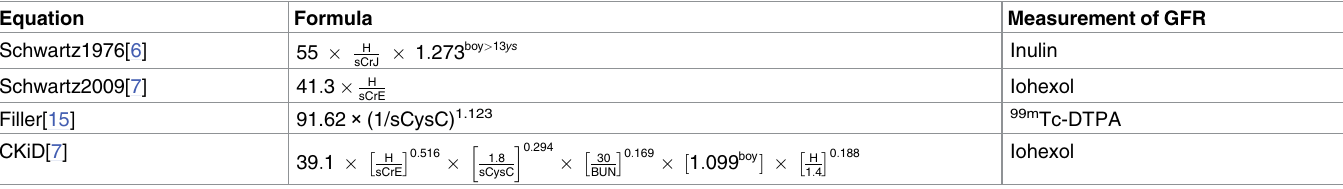
ratio of eGFR within mGFR±10% and mGFR±30% and the ratio of correct CKD staging by eGFR were used to compare the accuracy of GFR estimation of different equations.